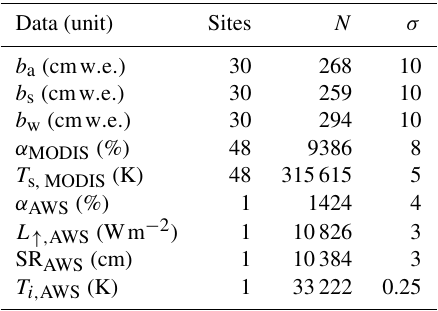
Table 3. Data used for calibration: point annual ( b a ), summer ( b s ), winter ( b w ) mass balances, albedo ( α ), surface temperature from MODIS ( T s, MODIS ), longwave outgoing radiation ( L ↑ , AWS ) and surface-height changes (SR AWS ) from a sonic ranger. Subscript AWS indicates that data are from the automatic weather station at Etonbreen. T i, AWS is snow and ice temperatures measured by a ther- mistor string next to the Etonbreen AWS. Sites indicate the number of sites for which each of the listed data variables are available, N is the total number of observations, and σ is the assumed observation